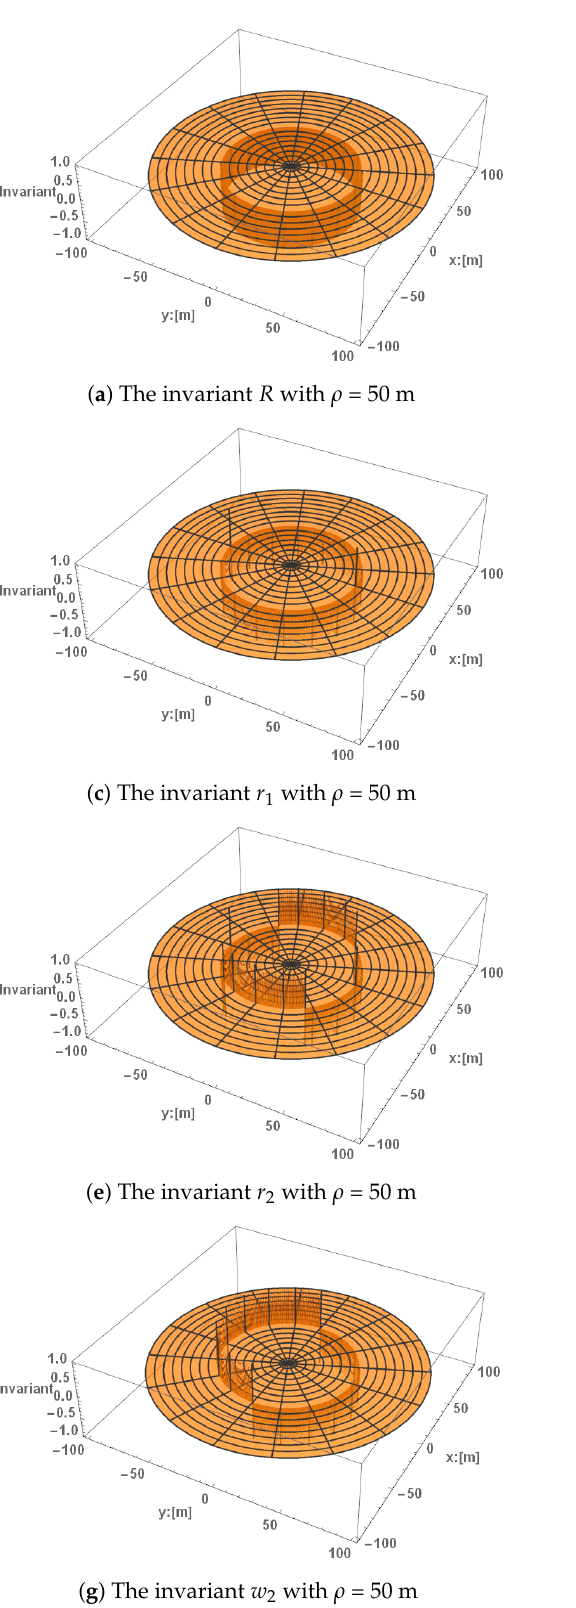
Figure A11. The warp bubble radius for the R , r 1 , r 2 , and w 2 for the Natário warp drive at a constant velocity. The other parameters were chosen to be v “ 1 c , and σ = 50, 000 m ´ 1 in natural